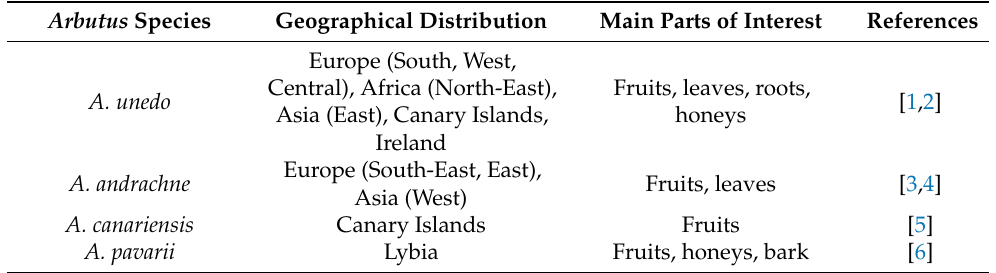
Table 1. List of accepted Arbutus species, geographical distribution and main parts of